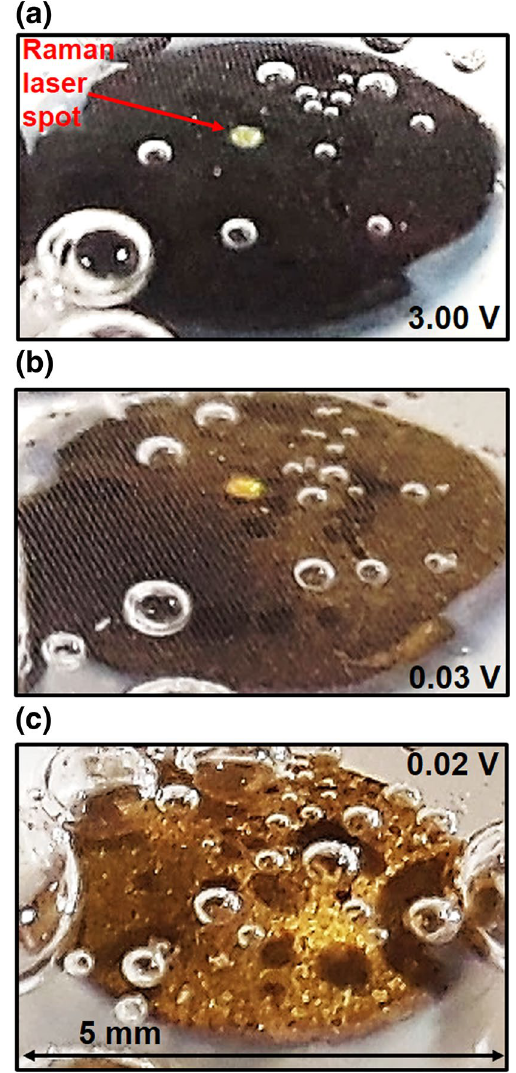
Fig. 3 In-situ optical images of the graphene nanoflake-based anodes depicting the following colours: a black at 3.00 V (no lithium); b reddish-yellow at 0.03 V (partially lithiated), and c golden yellow at 0.02 V (fully